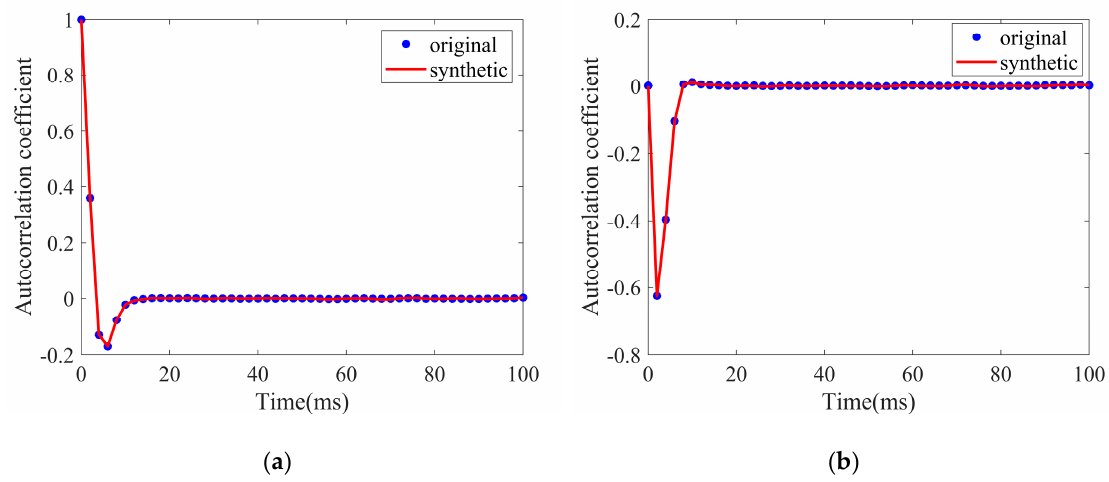
Figure 10. Average correlation coefficients of speckle: ( a ) Autocorrelation; ( b ) Cross-correlation.